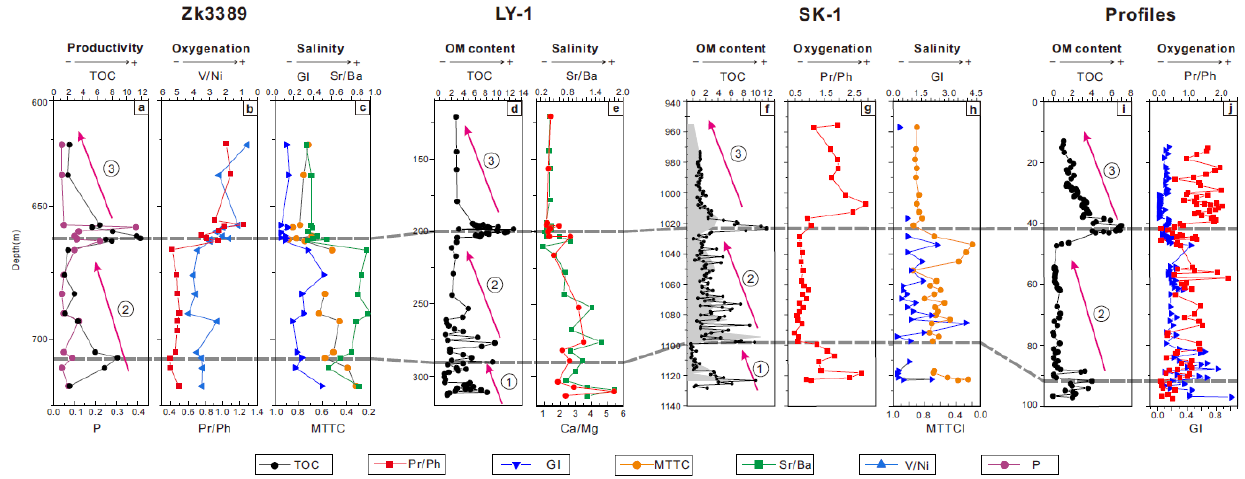
Figure 3. Environmental proxies from the Nenjiang Formation Member 1 and Member 2 from four study sites. Productivity